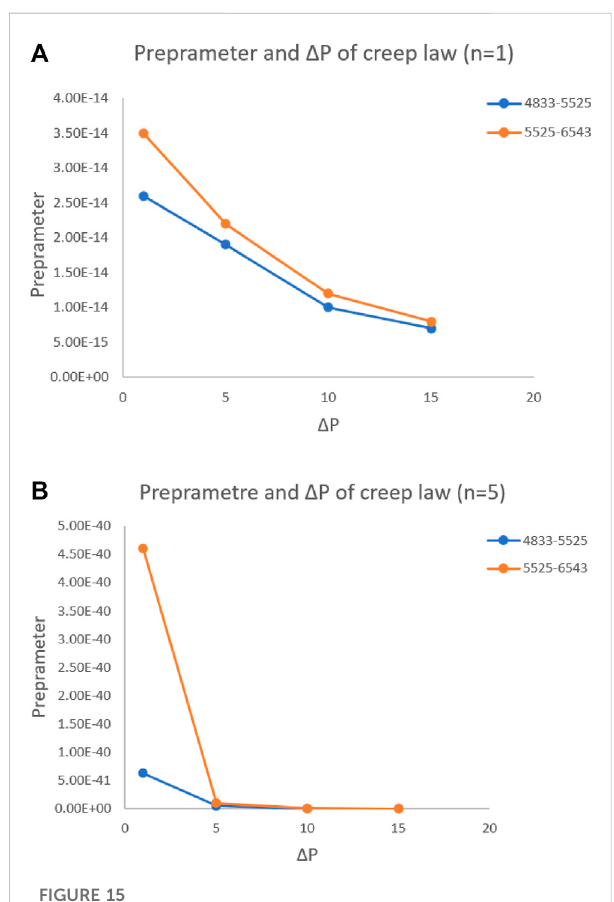
FIGURE 15 (A) Creep pre-coef fi cient vs horizontal stress difference (n = 1). (B) . Creep pre-coef fi cient vs horizontal stress difference (n =